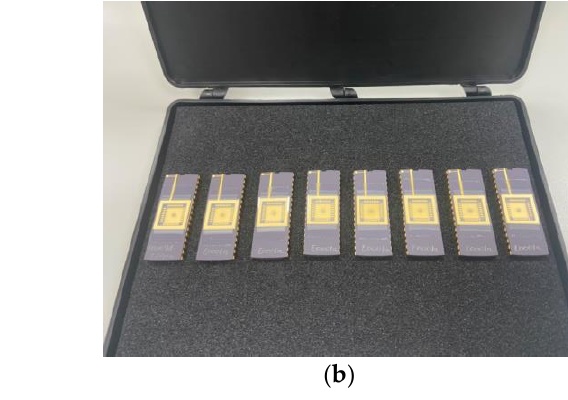
Figure 15. ( a ) IC photography. ( b ) IC outward appearance.